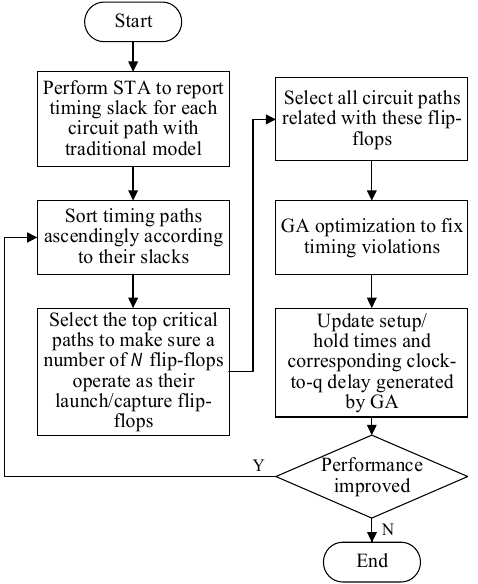
Figure 10. Illustration of iterative partial optimization method. Algorithm 1 GA optimization 01.